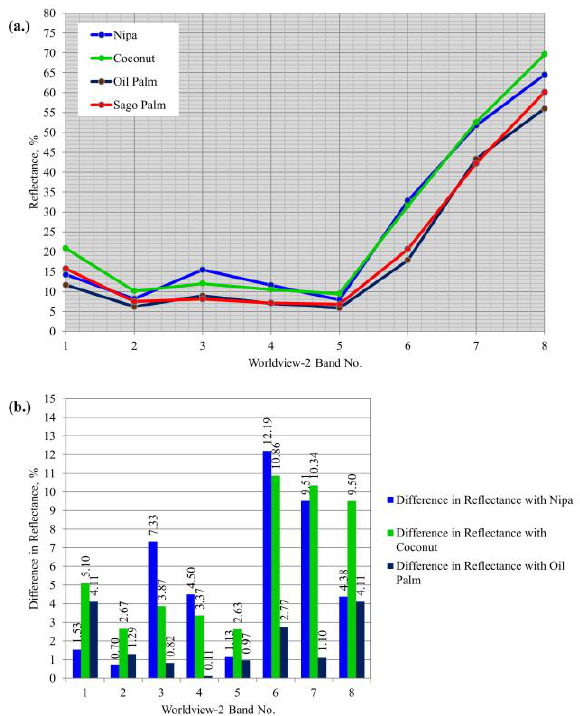
Figure 6. (a.) Resampled in-situ reflectance values of Sago and other palms in Bands 1-3 of ASTER VNIR; (b.) Difference in resampled in-situ reflectance of Sago with those of other palms.